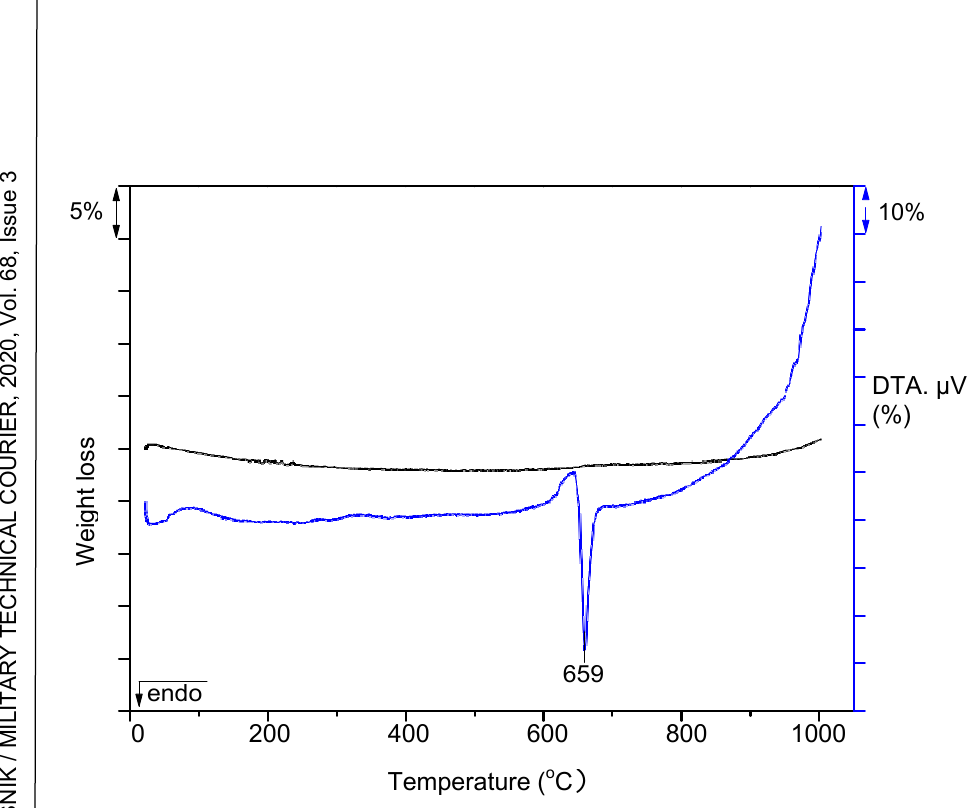
Figure 9 – Thermal analysis (DTA/TG) of a sample of conductive fibers Рис . 9 – Термический анализ ( ДТА / ТГ ) образца проводящих волокон Слика 9 – Термијска анализа (DTA/TG) узорка проводљивих